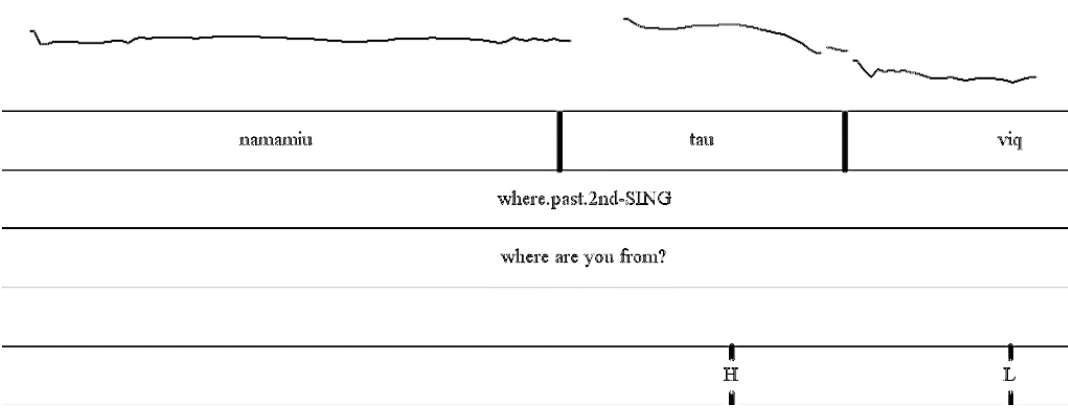
Figure 4. Rising intonation contour produced by a female speaker from Baker Lake (Shokeir 2009, p. 21).